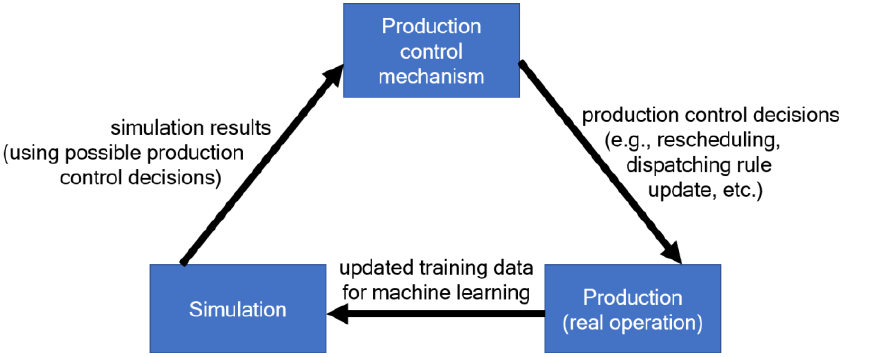
Figure 1. The considered production control mechanism.